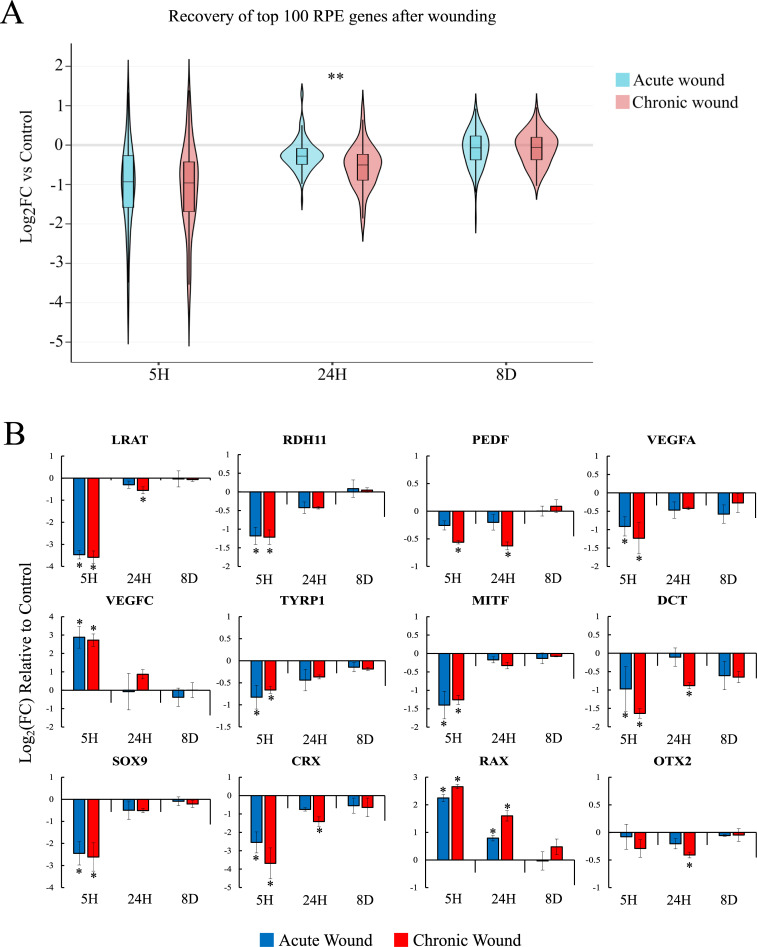
Systemic misregulation of RPE genes following wounding.(A) Violin plot showing Log2FC of the top 100 RPE genes in acutely wounded (blue) or chronically wounded (red) RPE cells (** = p-value<0.0001). (B) Bar graphs of select RPE genes showing Log2FC of acute or chronic wounding at 5H, 24H, and 8D compared to unwounded controls (mean ± SD, n = 3,* indicates p-value<0.01, see S3 Table).